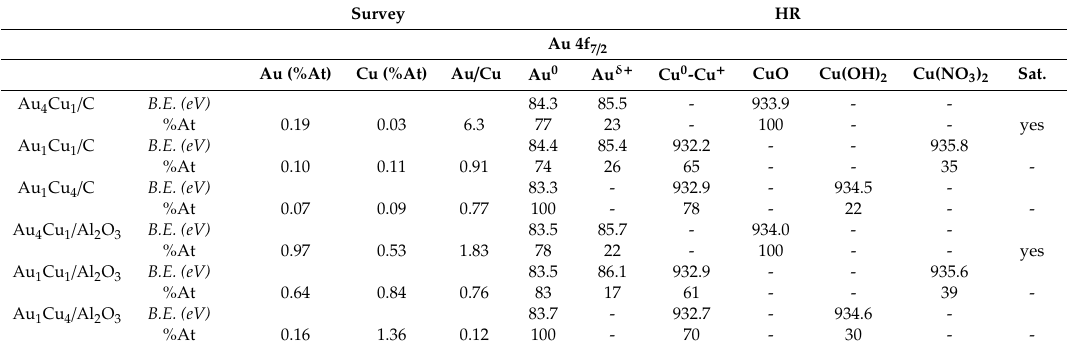
Table 2. X-ray photoelectron spectroscopy (XPS) high-resolution spectra and survey analyses of C- and Al 2 O 3 -supported